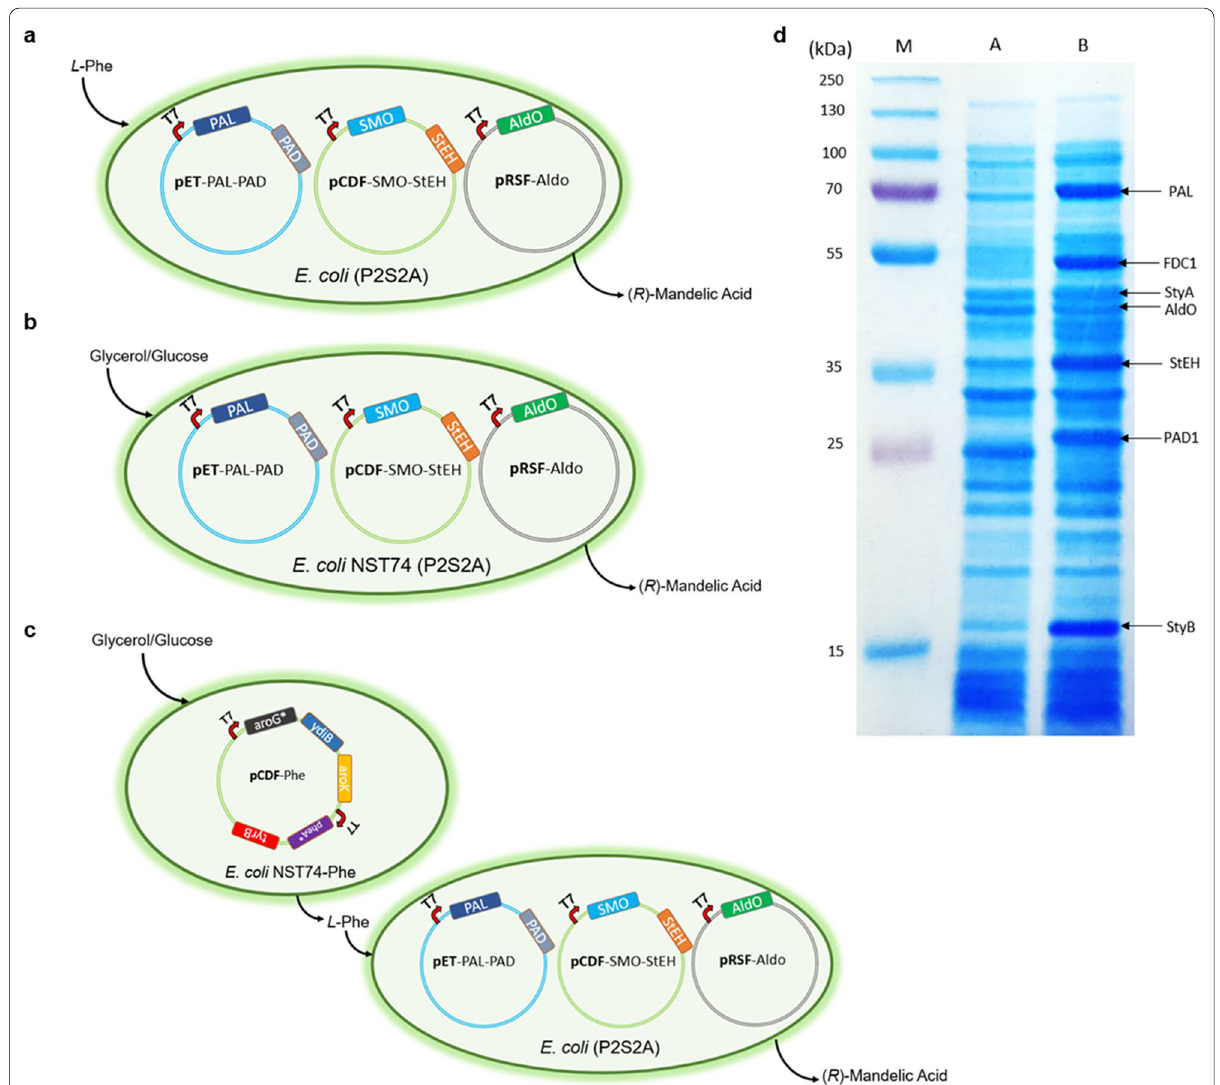
Fig. 1 Construction of E. coli cells co-expressing multiple enzymes for the bioproduction of ( R )-MA. a E. coli (P2S2A) strain harbouring plasmid pET-PAL-PAD encoding PAL and PAD, plasmid pCDF-SMO-StEH encoding SMO and StEH, and plasmid pRSF-AldO encoding AldO for the conversion of L- phenylalanine to ( R )-MA. b E. coli NST74 (P2S2A) strain harbouring plasmid pET-PAL-PAD encoding PAL and PAD, plasmid pCDF-SMO-StEH encoding SMO and StEH, and plasmid pRSF-AldO encoding AldO for the conversion of glycerol or glucose to ( R )-MA. c Coupled E. coli NST74-Phe strain over-expressing five limiting enzymes in Shikimate pathway with E. coli (P2S2A) expressing five-enzyme artificial cascade for the conversion of glycerol or glucose to ( R ) - MA. d SDS-PAGE. Lane M: protein marker; Lane A: total intracellular protein of E. coli NST74; Lane B: total intracellular protein of E. coli NST74